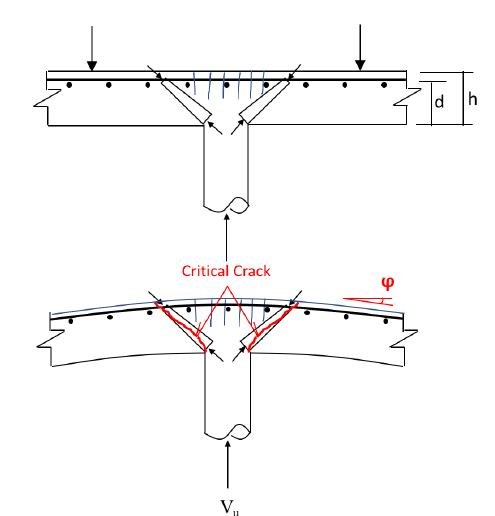
Figure 2. Muttoni's Critical Shear Crack Theory